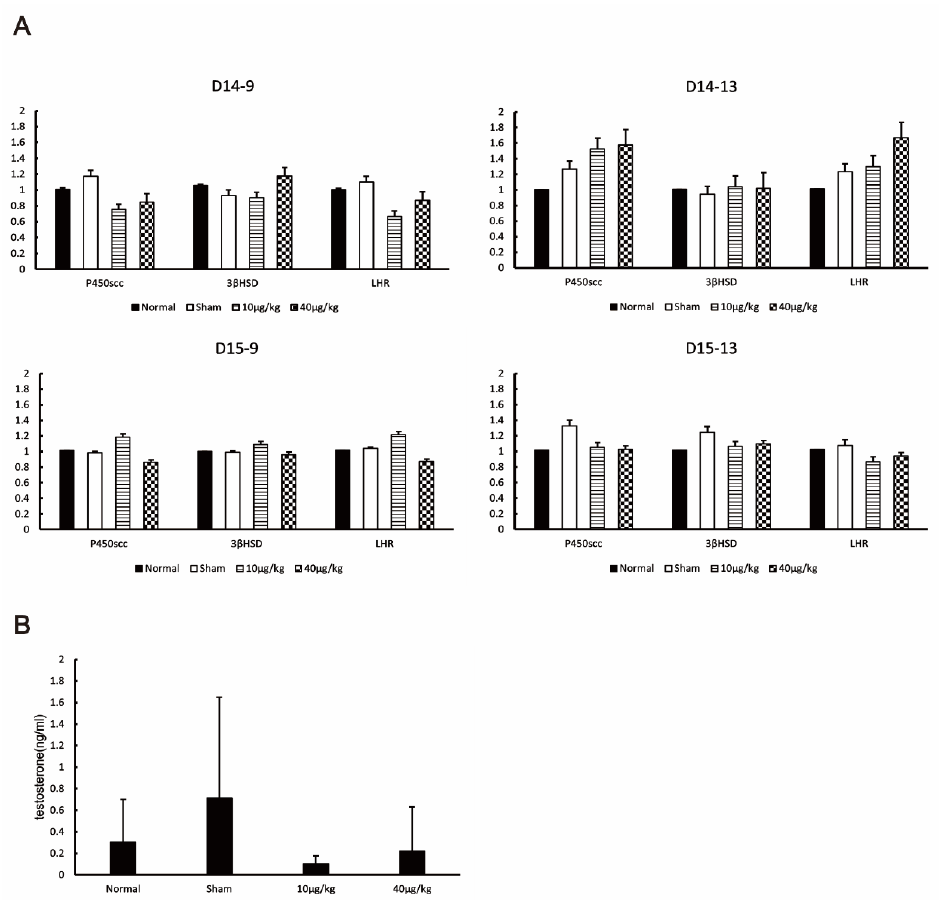
Figure 4. Effects of DEX administration on androgens. ( A ) The expression levels of cholesterol side-chain cleavage cytochrome P450 (P450scc), 3 beta-hydroxysteroid dehydrogenase (3 β HSD), and luteinizing hormone receptor (LHR) at each testis collection point were measured by RT-PCR. The values are presented as means ± SDs. ( B ) The testosterone concentration in the blood of mice from each group collected by D15-13 was measured by ECLIA. The values in the graph are presented as means ± SDs. Testosterone concentrations were not significantly different among the four groups based on the Kruskal–Wallis test ( p = 0.429). The sampling points after 14 days of continuous DEX administration from mice were 9:00 on day 14 (D14-9), 13:00 on day 14 (D14-13), 9:00 on day